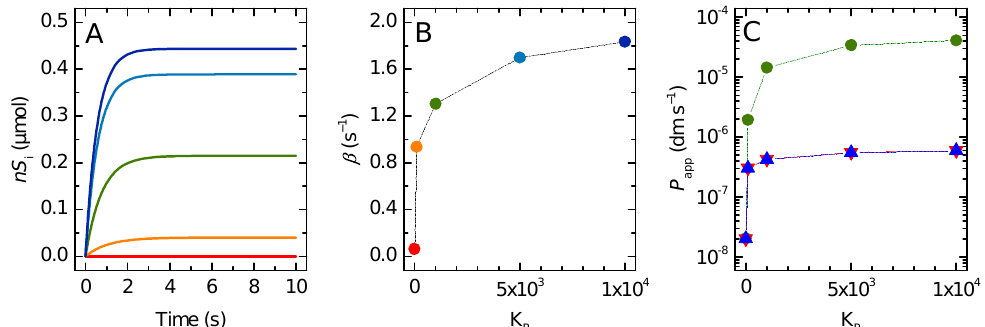
Figure 4. ( A ) Evolution of the number of moles of solute inside the vesicles when varying the partition coefficient of a non-ionisable solutes for partition coefficients 1 ( — ), 10 2 ( — ), 10 3 ( — ), 5 × 10 3 ( — ) and 10 4 ( — ). ( B ) Characteristic constant of solute accumulation inside the vesicles as a function of the partition coefficient. ( C ) Apparent permeability coefficient calculated from the general equation ( P app • ), and from the simplified equation ( P r app (cid:72) and P rV app (cid:78) ), as a function of the partition coefficient, with the total area of the barrier calculated from Equation (12). Note the logarithmic scale of the y axis. The dotted lines in panels B and C are guides for the